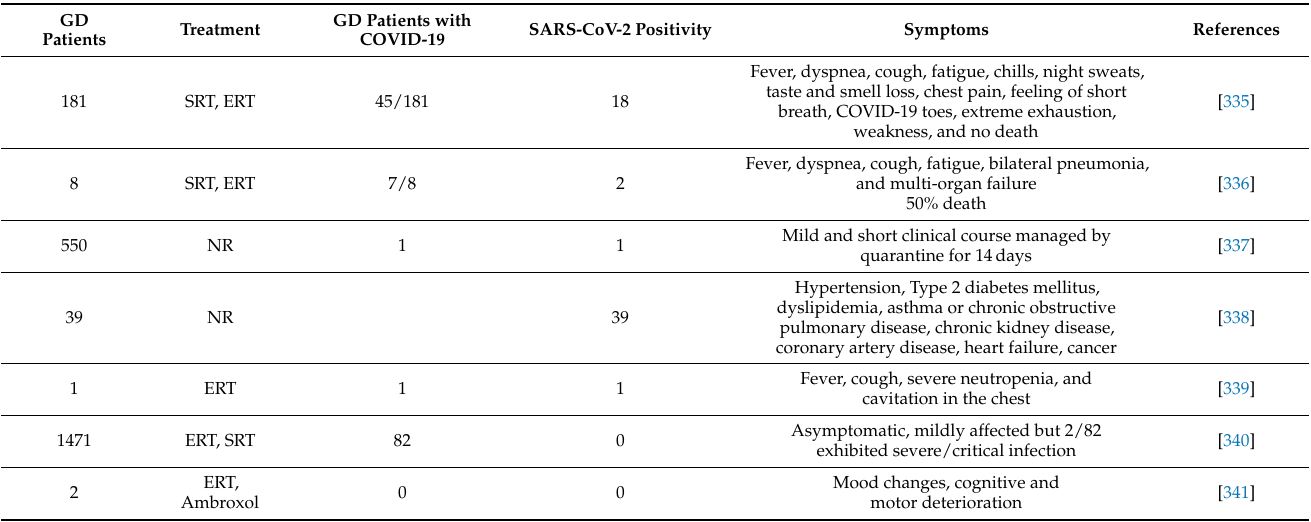
Table 8. Effect of COVID-19 in Patients with Gaucher Disease. GD